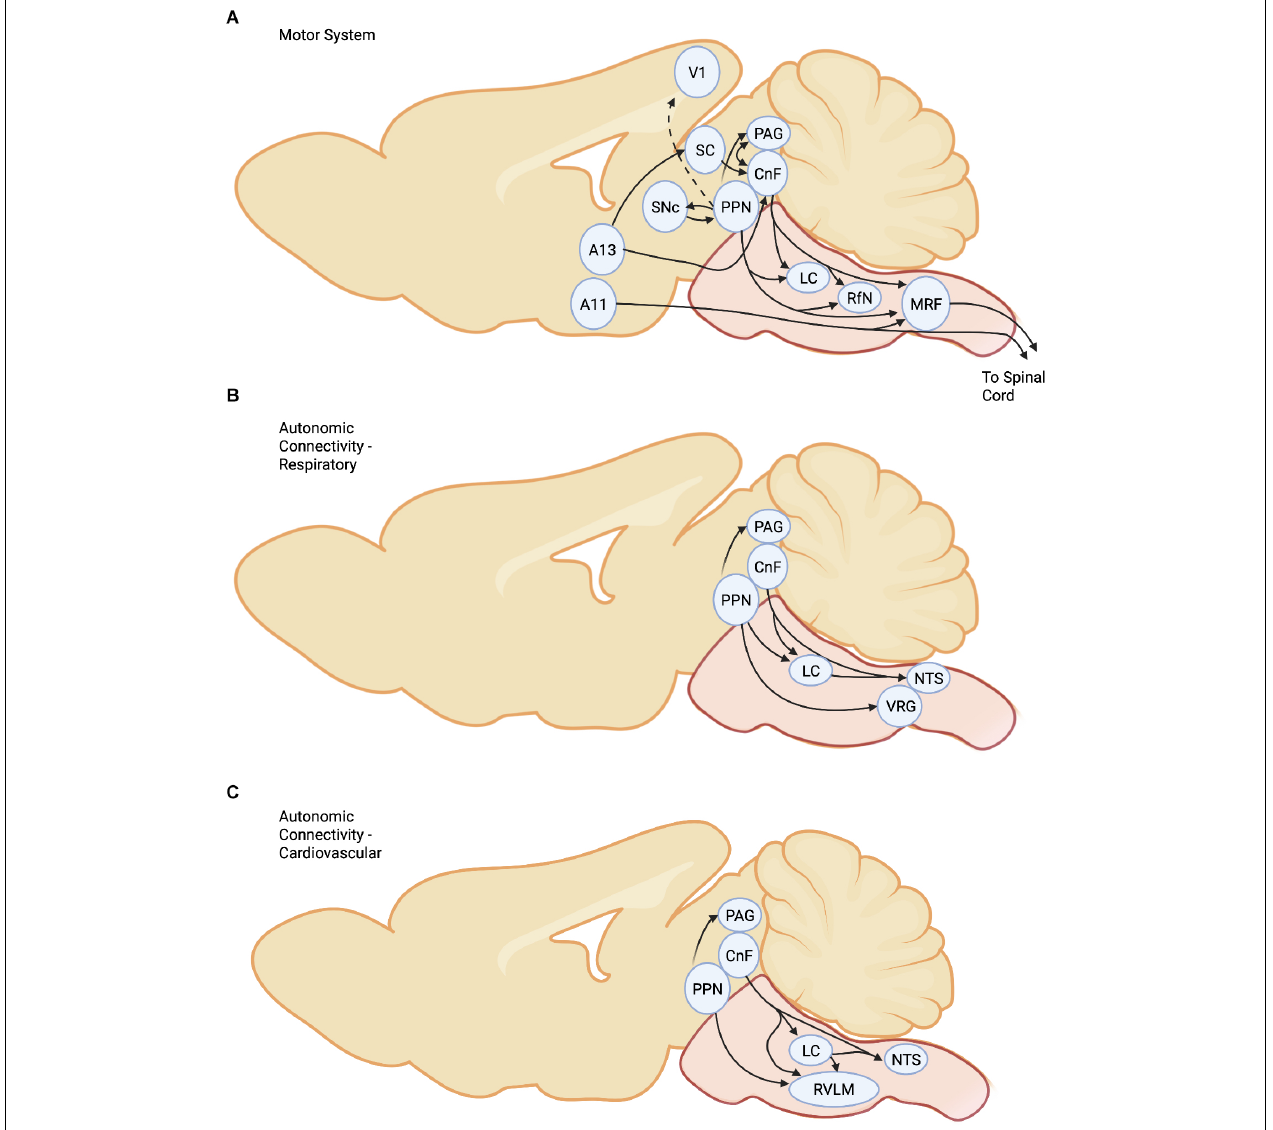
FIGURE 1 | Connectivity of the MLR for (A) Motor System, (B) Respiratory System, and (C) Cardiovascular system. Abbreviations. CnF , Cuneiform Nucleus; LC , Locus Coeruleus; PPN , Pedunculopontine Nucleus; SC , Superior Colliculus; SNc , Substantia Nigra compacta; PAG , Periaqueductal Gray; RfN , Raphe Nucleus; MRF , Medullary Reticular Formation; NTS , nucleus tractus solitarii; RVLM , rostral ventrolateral medulla; VRG , Ventral Respiratory Group; V1 , primary visual